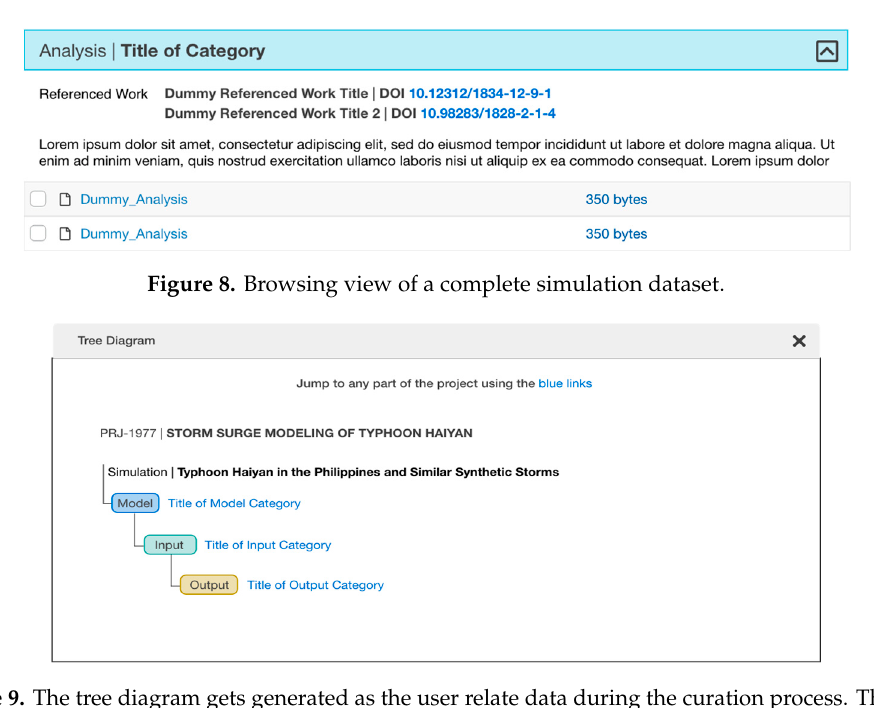
Figure 9. The tree diagram gets generated as the user relate data during the curation process. The tree becomes a navigation tool to files in the dataset’s landing page.